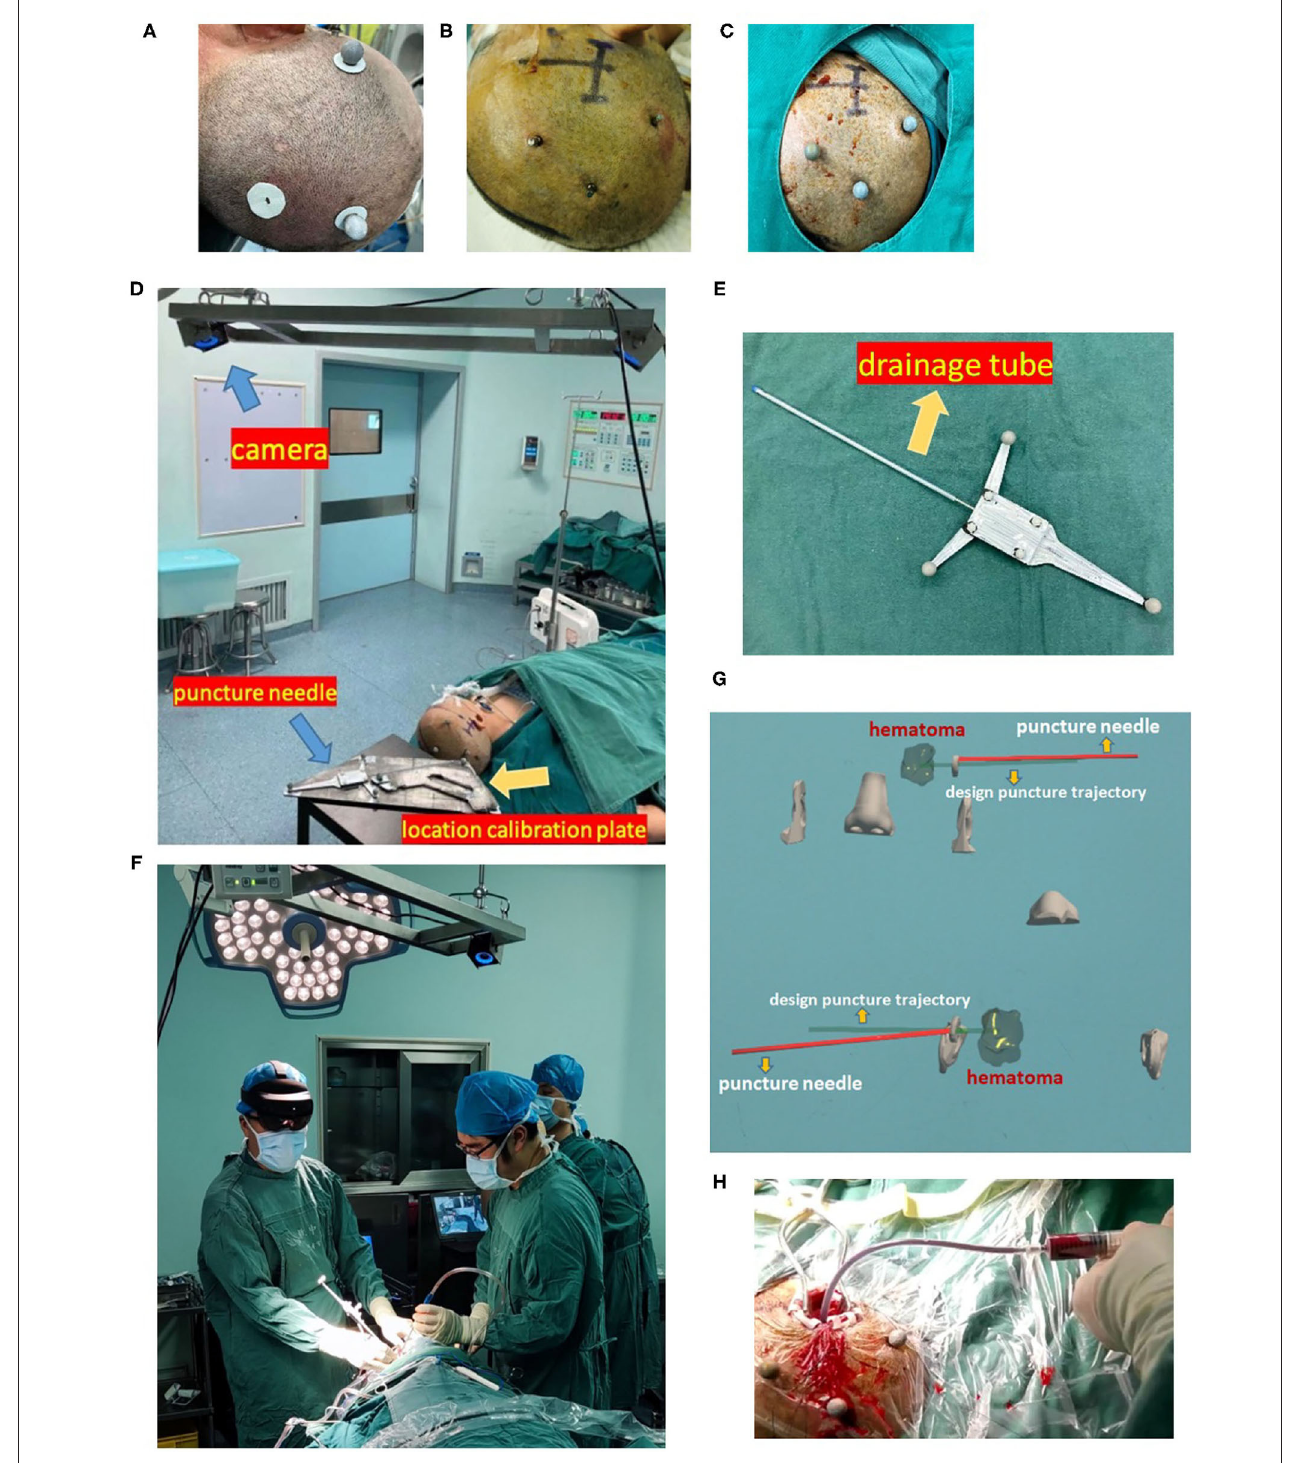
FIGURE 2 | Workflow of the minimally invasive puncture and drainage of hypertensive intracerebral hemorrhages by mixed reality holographic navigation technology. (A) Patients wore three sticky analysis markers around the puncture area. (B) A bone nail was drilled through the hole in the sticky marker base, which was replaced with sticky analysis markers, and these “twin marker” ensured no obvious deviation in the location of markers. (C) After disinfection, a sterilized analysis marker was installed on the bone nail. (D) Three-dimensional coordinate data of the location calibration plate, puncture needle, and head were captured by a camera. (E) Combination of a puncture needle and drainage tube. (F) Wearing HoloLens, the surgeon used MRHNT for hematoma puncture. (G) Wearing HoloLens, the surgeon actually viewed the two planes of the image. (H) After hematoma puncture was completed, the hematoma was aspirated from the drainage tube.